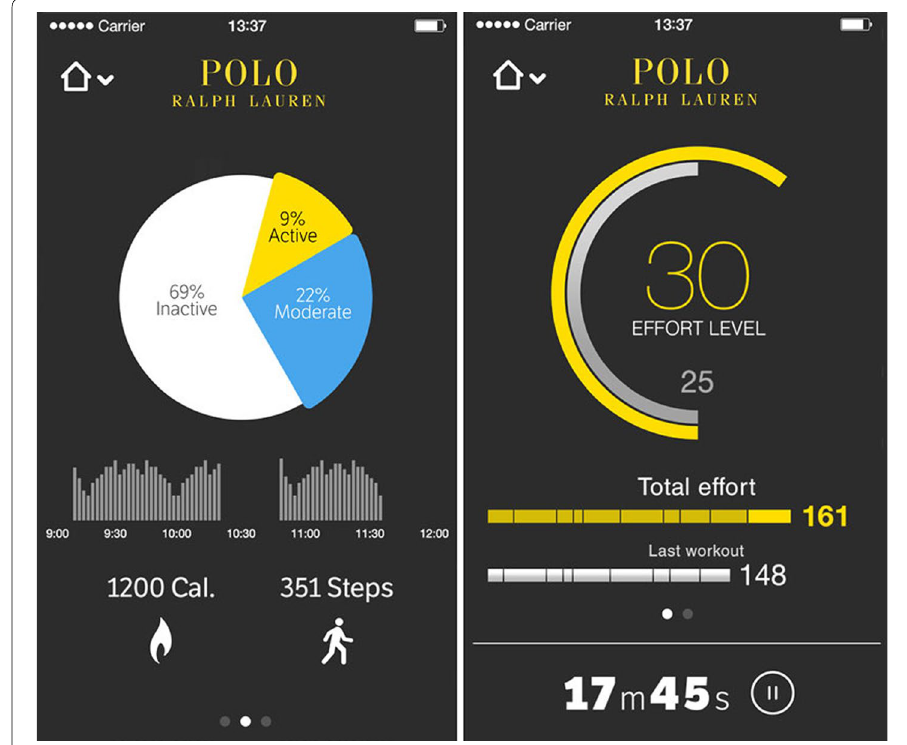
Fig. 9 Polo Tech shirt dashboard. Photograph: Courtesy of Ralph